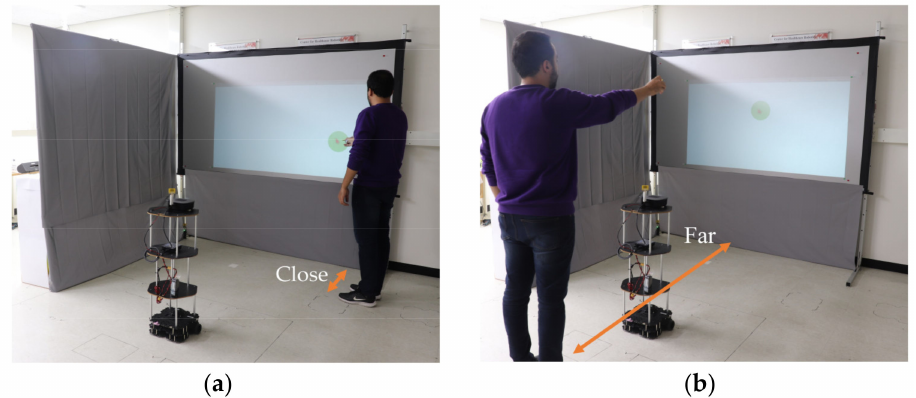
Figure 9. Stage 1 subparts: ( a ) Close distance interaction; ( b ) far distance